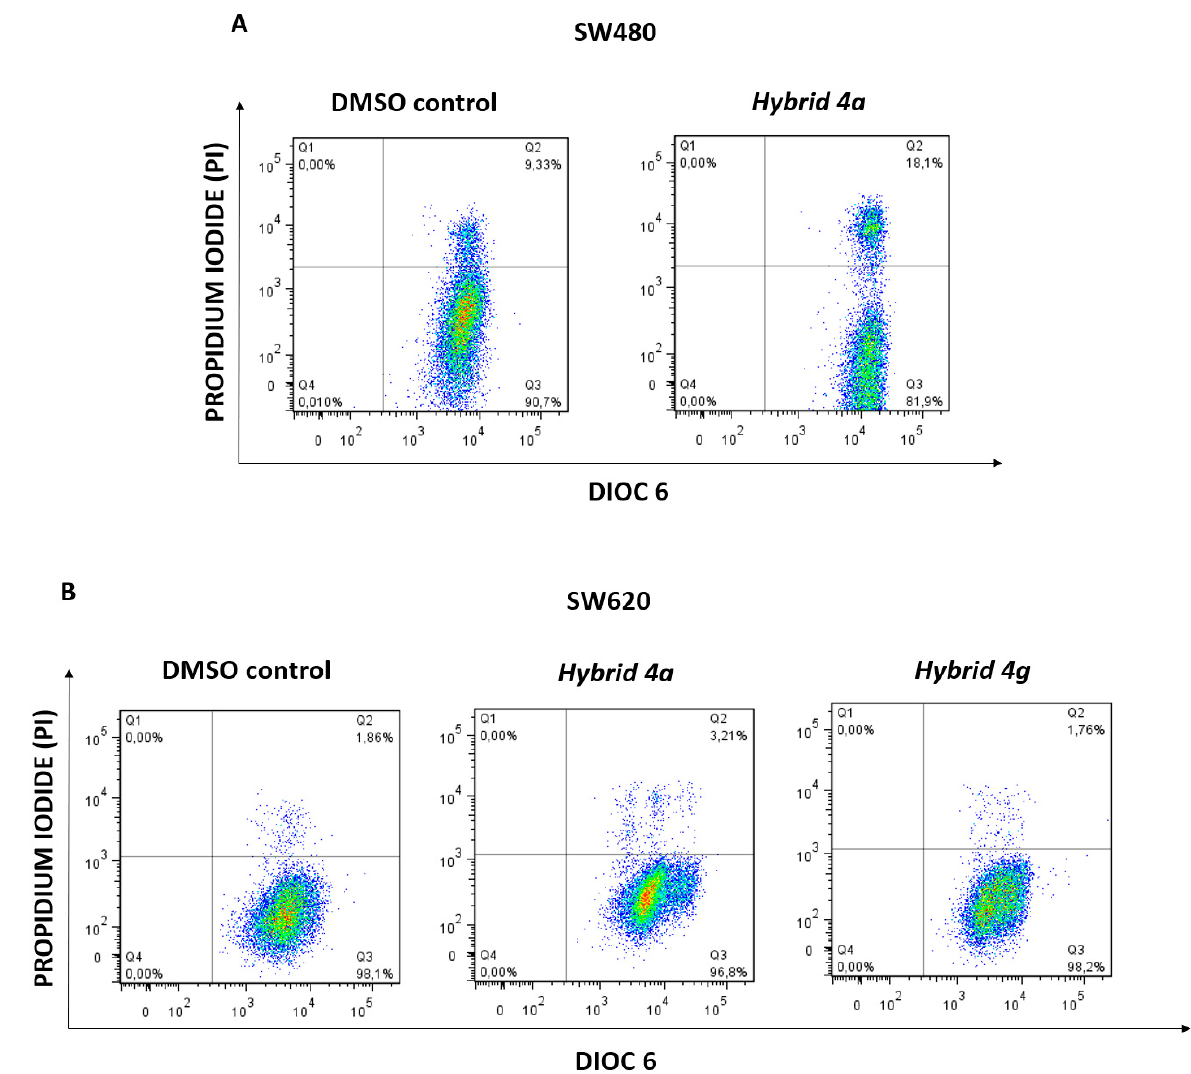
Figure 6. Changes in ∆Ψ m and plasma membrane integrity. Flow cytometric analysis of cells after treatment with hybrids 4a and 4g in ( A ) SW480 and ( B ) SW620 cells. Q1 + Q2: PI positive cells, with membrane damage or dead cells; Q3: live cells with high ∆Ψ m; Q4: cells in latency that lose ∆Ψ m.